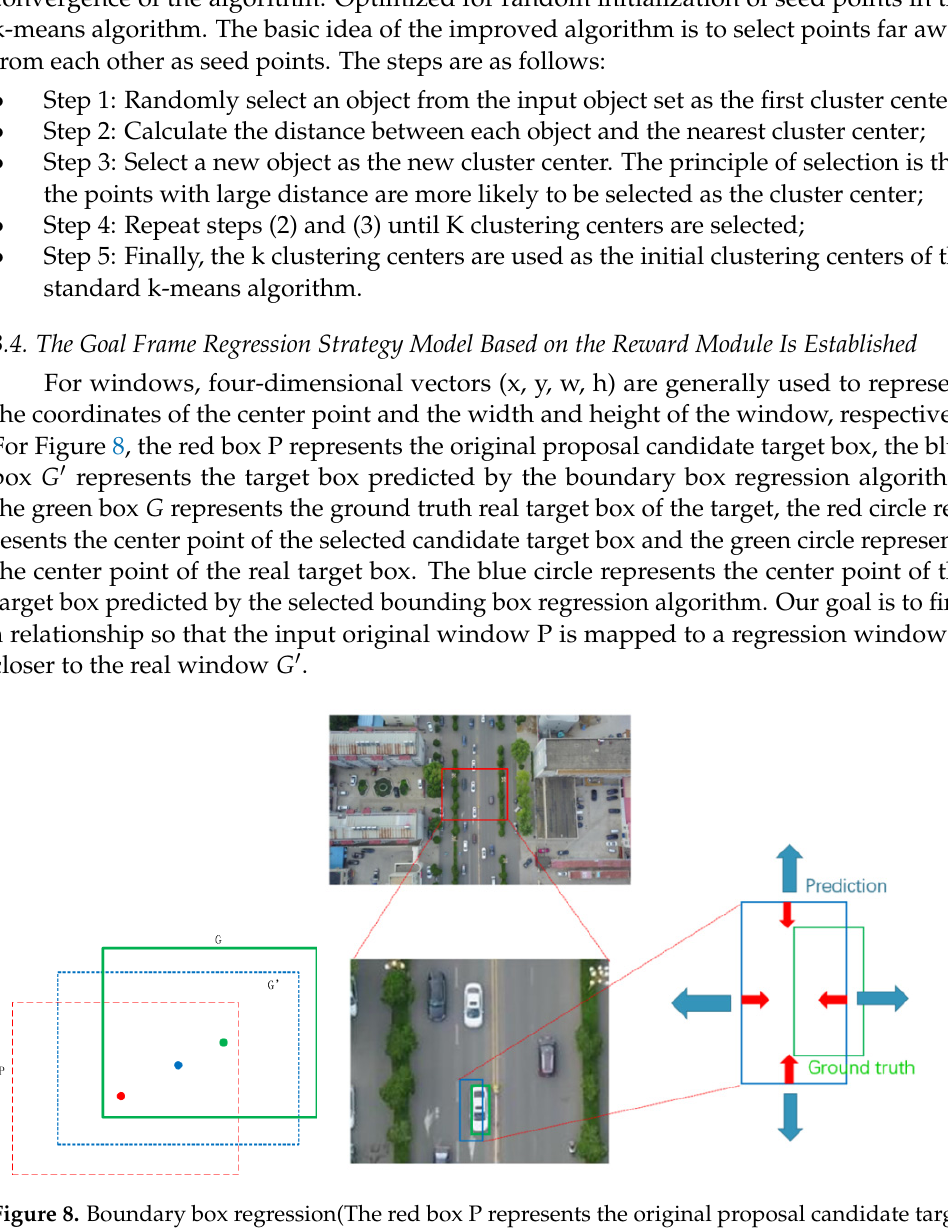
Figure 8. Boundary box regression(The red box P represents the original proposal candidate target box, the blue box G (cid:48) represents the target box predicted by the bounding box regression algorithm, the green box G represents the ground truth target box of the target, the red circle represents the center point of the candidate frame, the green circle represents the center point of the real target frame, and the blue circle represents the center point of the selected bounding box regression algorithm predicts the target box).